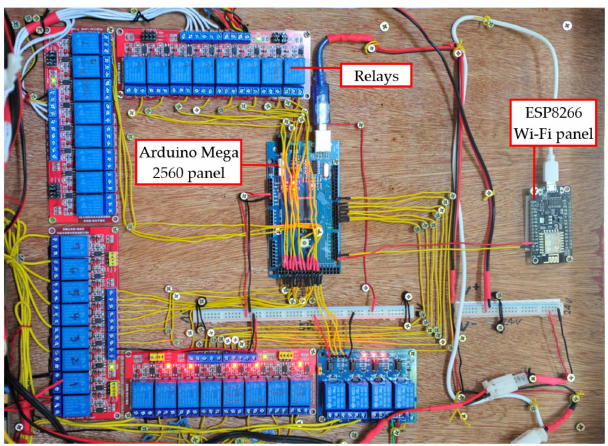
Figure 12. Prototype of contact-free epidemic prevention elevator system.